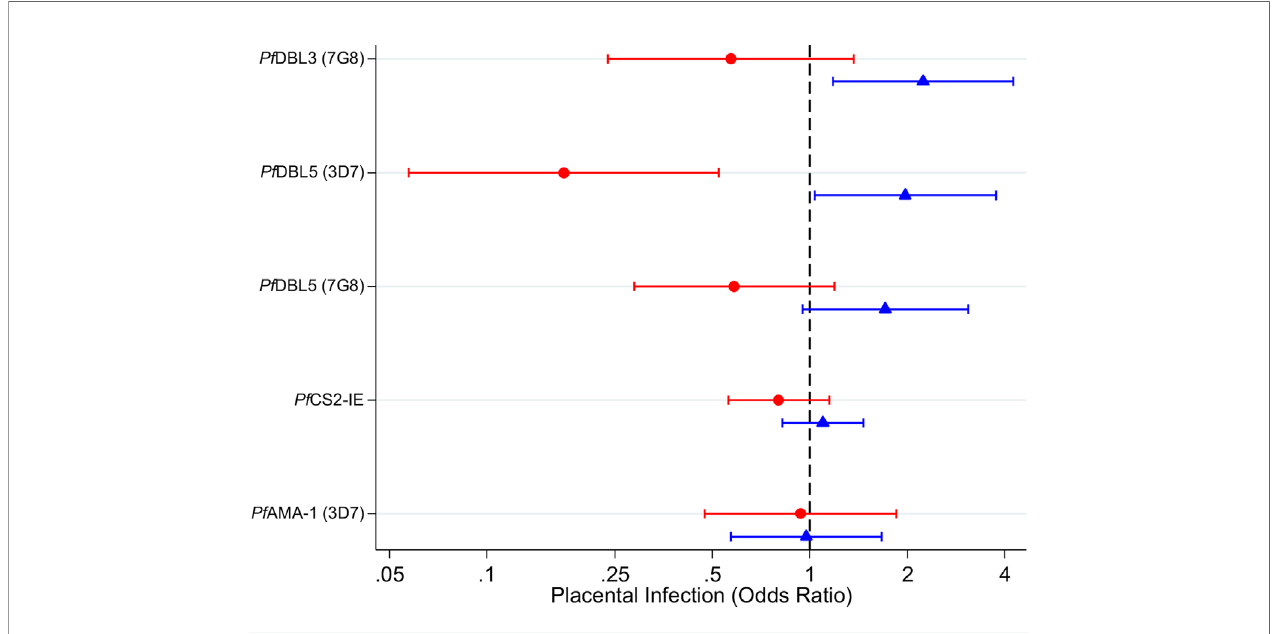
FIGURE 2 | Adjusted odds ratios for placental P. falciparum infection in individuals with high antibody levels (75 th percentile) relative to individuals with low antibody levels (25 th percentile) in women infected at enrolment (red circles) and uninfected at enrolment (blue triangles). Capped bars indicate 95% con fi dence intervals. See Supplementary Table 1 for a table with p values. See Supplementary Tables 2 and 3 for estimates from models fi tted with an interaction between antibodies and gravidity; and for estimates from models fi tted without an interaction